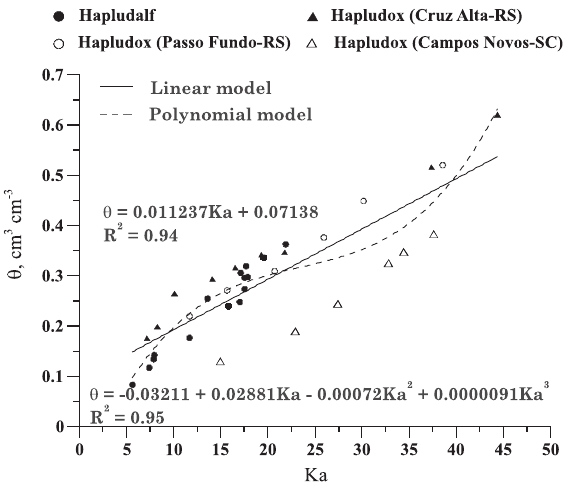
Figure 3. Relation between the dielectric constant (Ka) measured with the TDR-100 and the volumetric soil moisture ( θθθθθ ) determined and calculated by the linear and polynomial models.